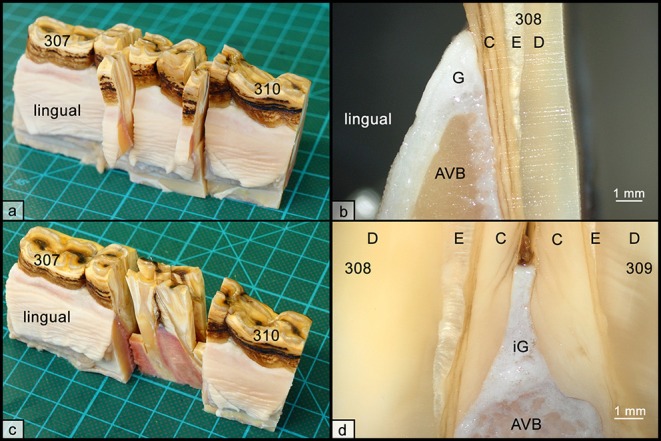
Histologic sampling collection, exemplary shown for teeth 308 and 309. (a) Non-interdental samples were collected by transverse sectioning of teeth 308 and 309. Sections were further divided to obtain separated specimens from the lingual and buccal aspect. (b) Each specimen contained the gingiva (G), parts of the alveolar bone (AVB), and dental substances, i.e., cementum (C), enamel (E), and dentin (D). (c) Interdental samples were collected by sagittal sections through teeth 308 and 309. (d) Each specimen contained the interdental gingiva (iG), attached to alveolar bone (AVB) and dental substances, i.e., cementum (C), enamel (E), and dentin (D).